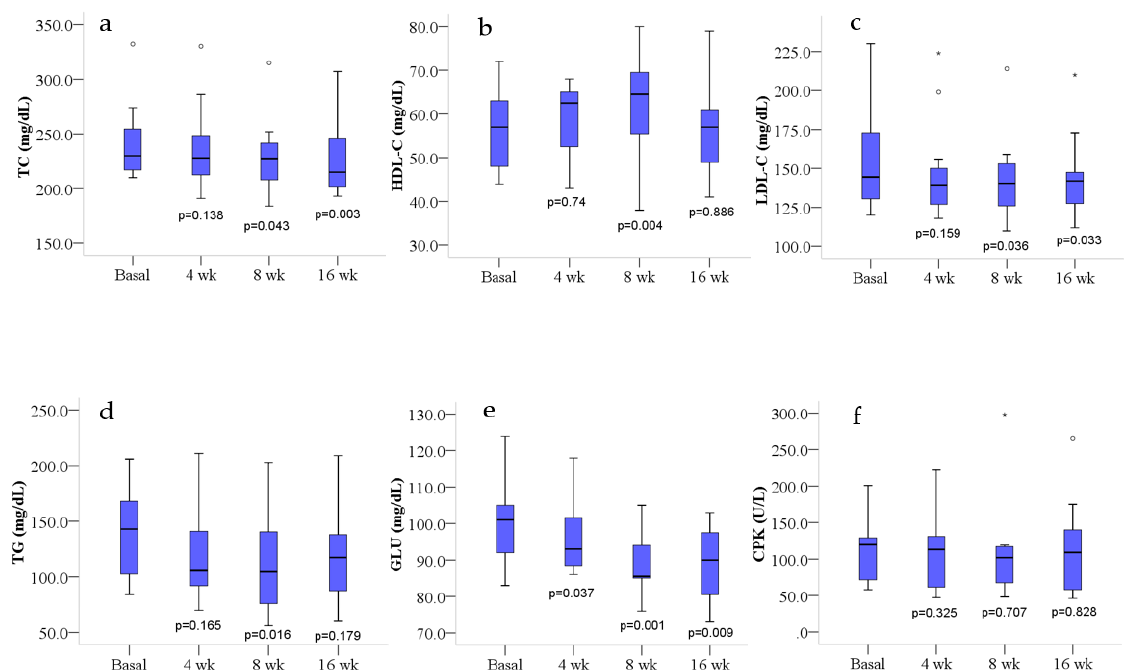
Figure 1. Lipids, glucose and CPK blood profile at basal level and after 4, 8 and 16 weeks of treatment. Box plots show median (horizontal line in the box), 25th and 75th percentiles (edges of box), maximum and minimum values (whiskers) and outliers ( ◦ , *) of: ( a ) total cholesterol (TC), ( b ) high-density lipoprotein cholesterol (HDL-C), ( c ) low-density lipoprotein cholesterol (LDL-C), ( d ) triglycerides (TG), ( e ) glucose (GLU) and ( f ) creatine phosphokinase (CPK) concentrations. p values measure the significance of differences compared with basal values (least significant difference); wk, weeks.